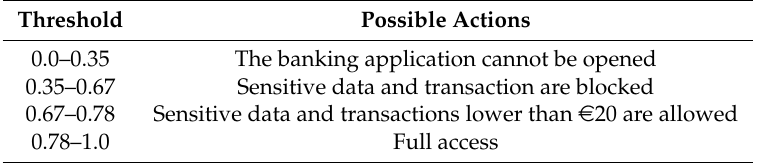
Table 12. Thresholds with AL score to perform different actions of the banking